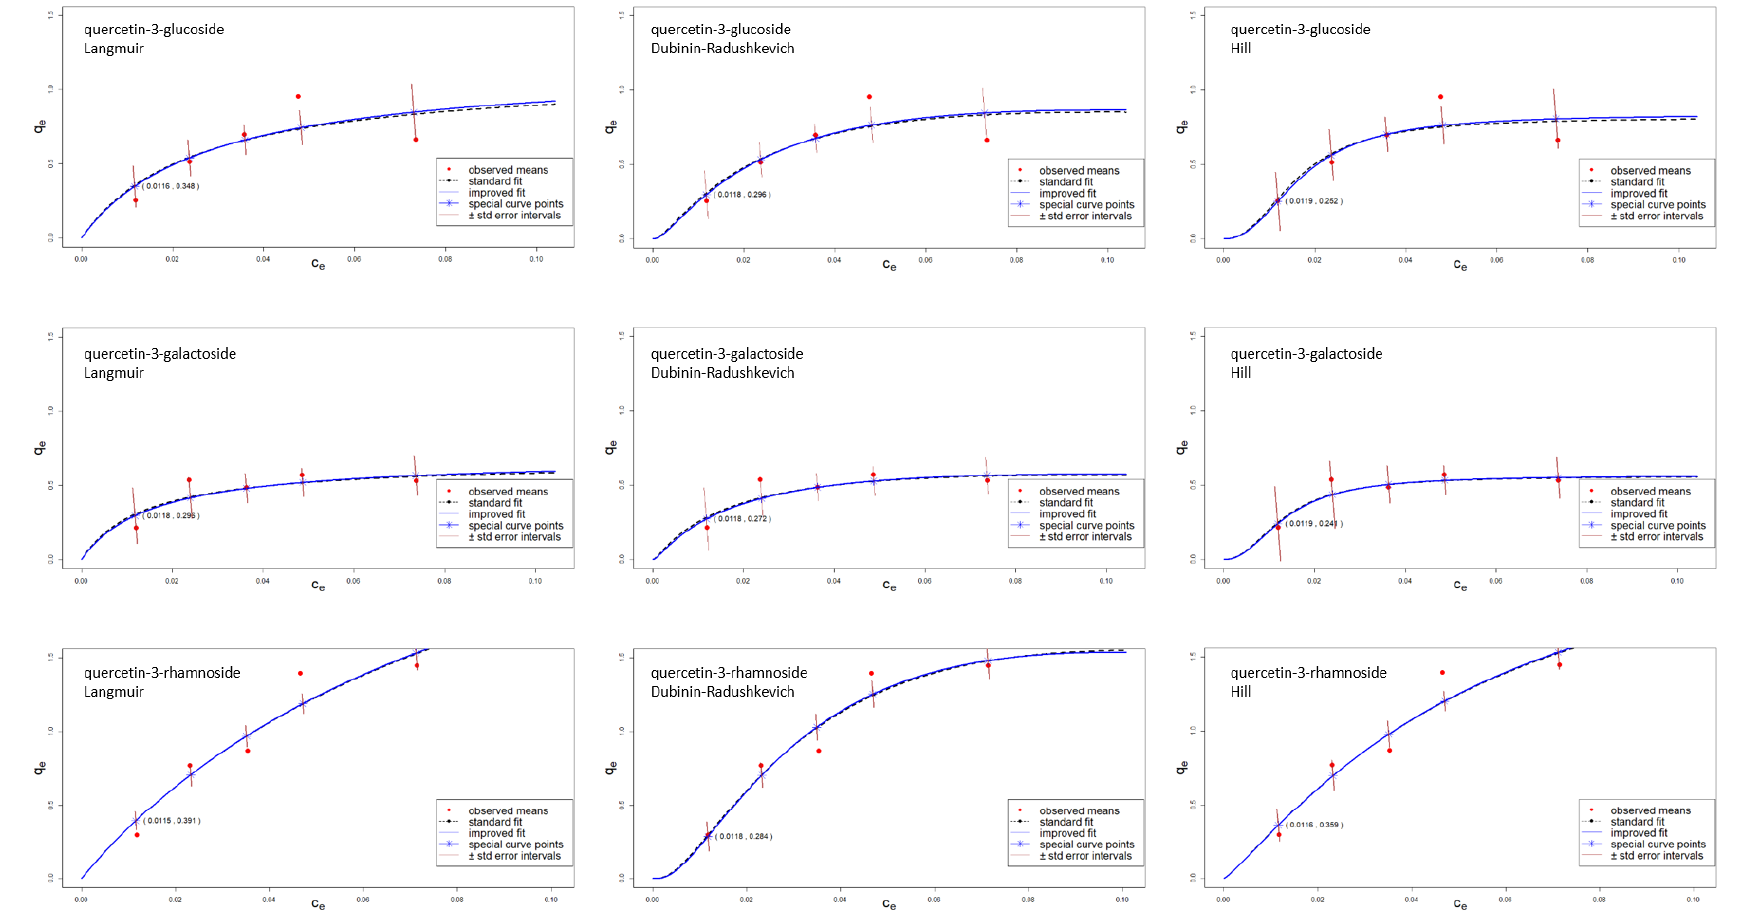
Figure 4. Langmuir, Dubinin-Radushkevich, and Hill isotherms of quercetin derivatives adsorption onto β -glucan obtained with novel improved non-linear regression (with reported q e , model at the lowest c e value) (the confidence intervals are ± 1 standard errors of the model fits).